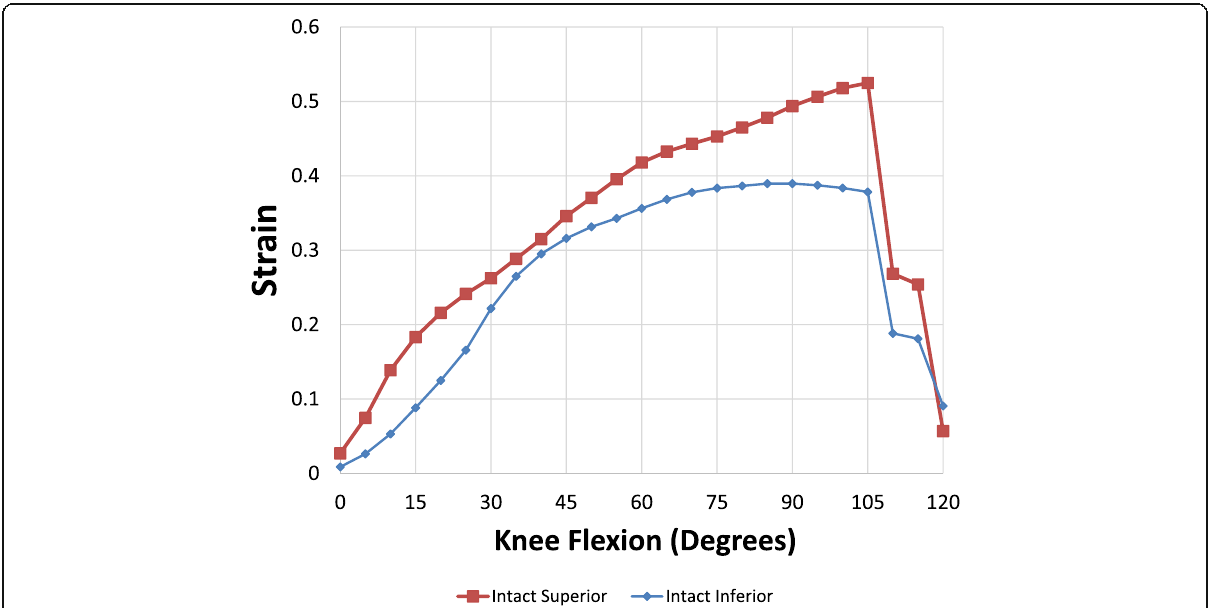
Fig. 5 Mean strain pattern of intact (native) MPFL as knee flexed from 0 to 120 degrees. Red – superior intact, Blue – inferior intact